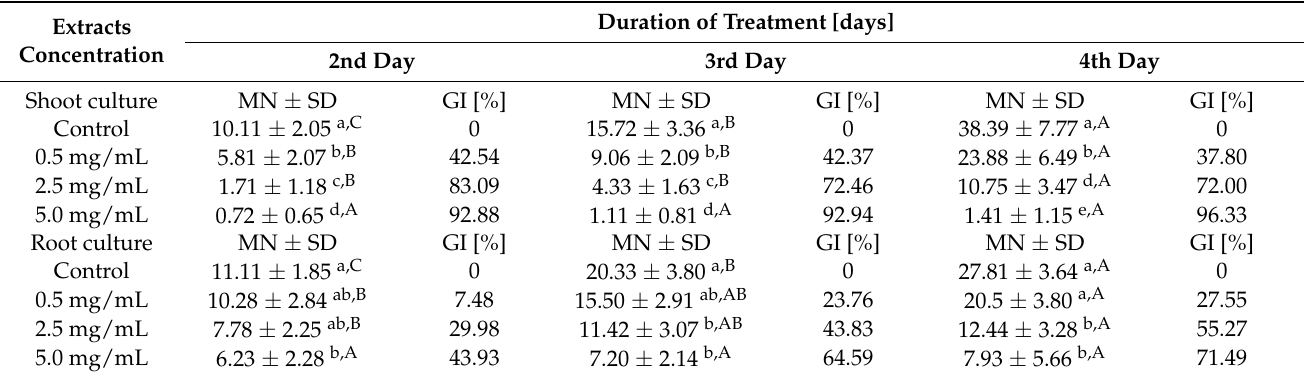
Table 5. Effect of extract from Eryngium campestre shoot and root in vitro cultures on inhibition of Acanthamoeba trophozoites during four days treatment.